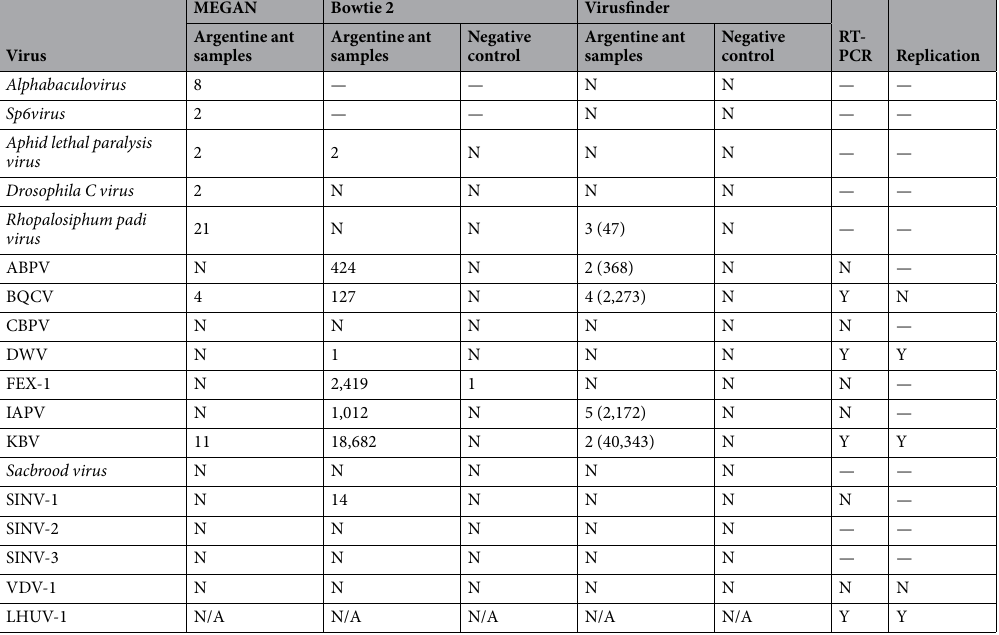
Table 1. Detection of known viruses from RNA-seq reads using MEGAN, Bowtie 2 and Virusfinder, and confirmation using RT-PCR. The MEGAN figures indicate the number of contigs detected for each given virus. The figures reported for Bowtie 2 are those reads that aligned concordantly 1 or more times or discordantly 1 or more times. Virusfinder results show the number of contigs (reads) that mapped to the virus. The RT- PCR column indicates if the virus was detected using RT-PCR, and the Replication column indicates whether replication of the virus was confirmed subsequent to RT-PCR. In each of the columns ‘-’ indicates the virus was not tested for and ‘N’ indicates non-detection. Acute bee paralysis virus (ABPV); Black queen cell virus (BQCV); Chronic bee paralysis virus (CBPV); Deformed wing virus (DWV); Formica exsecta virus 1 (FEX-1); Israeli acute paralysis virus (IAPV); Kashmir bee virus (KBV); Solenopsis invicta virus 1, 2 and 3 (SINV-1, SINV-2, SINV- 3); Varroa destructor virus 1 (VDV-1), Linepithema humile virus 1 (LHUV-1). LHUV-1 was not detected by MEGAN or Virusfinder as the sequence was not lodged in GenBank at the time the study was